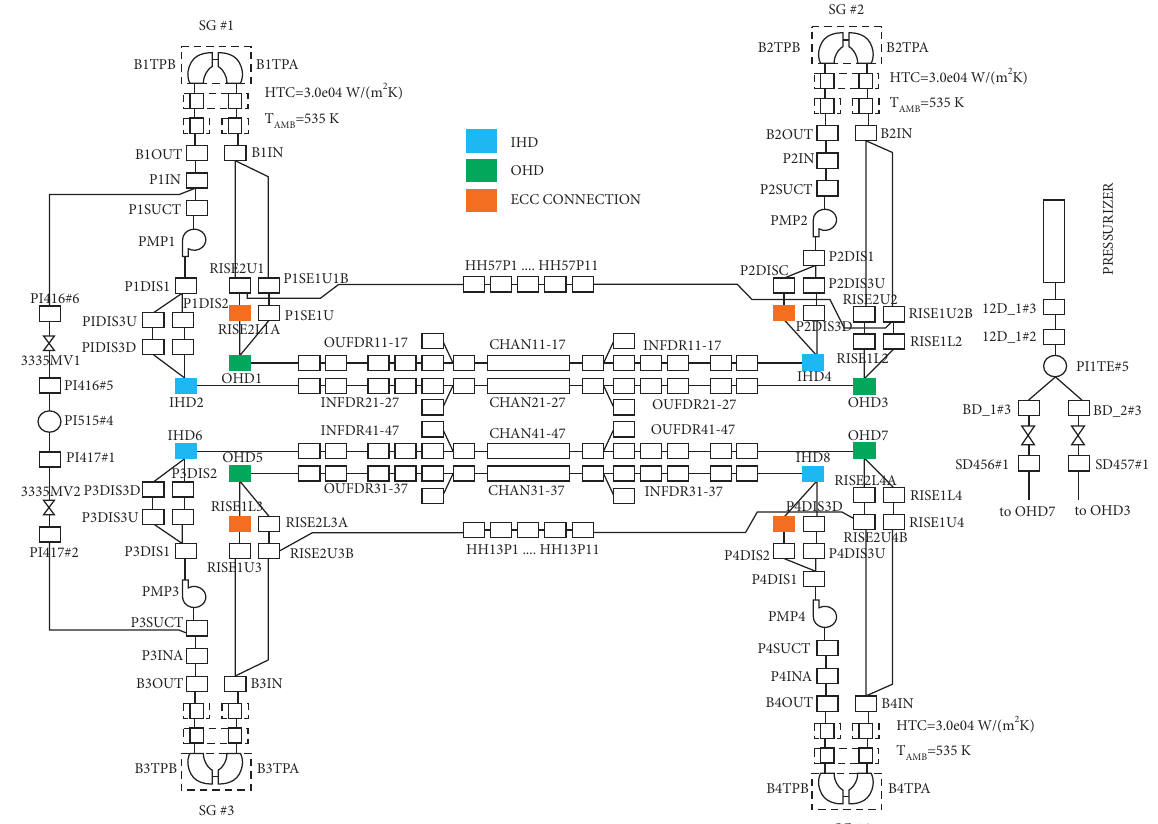
Figure 6: Thermal-hydraulic nodalization as specified by the benchmark